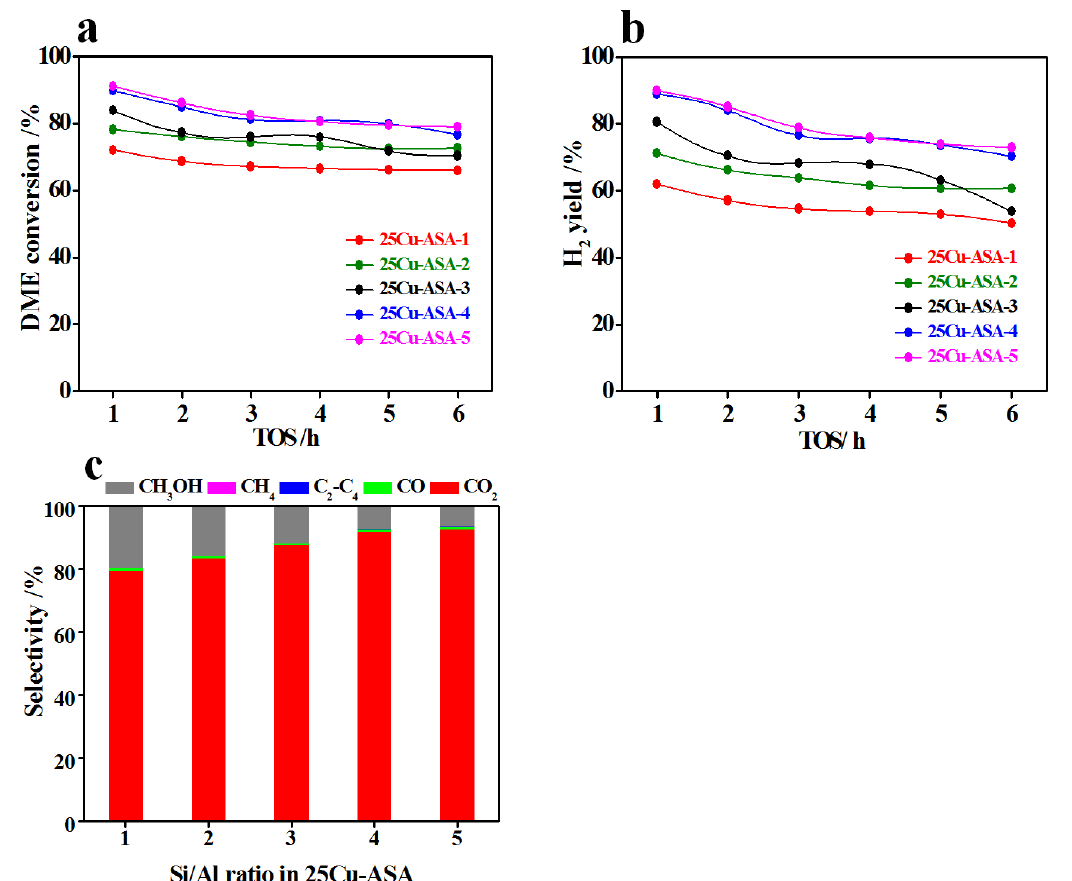
Figure 7. The SRD results for 25Cu–ASA- y under the reaction conditions of 300 °C, 0.1 MPa, and GHSV of 4000 h − 1 . ( a ) Time-on-stream DME conversions, ( b ) Time-on-stream H 2 yields, and ( c ) the selectivity of the carbon-containing products at a TOS of 6 h.